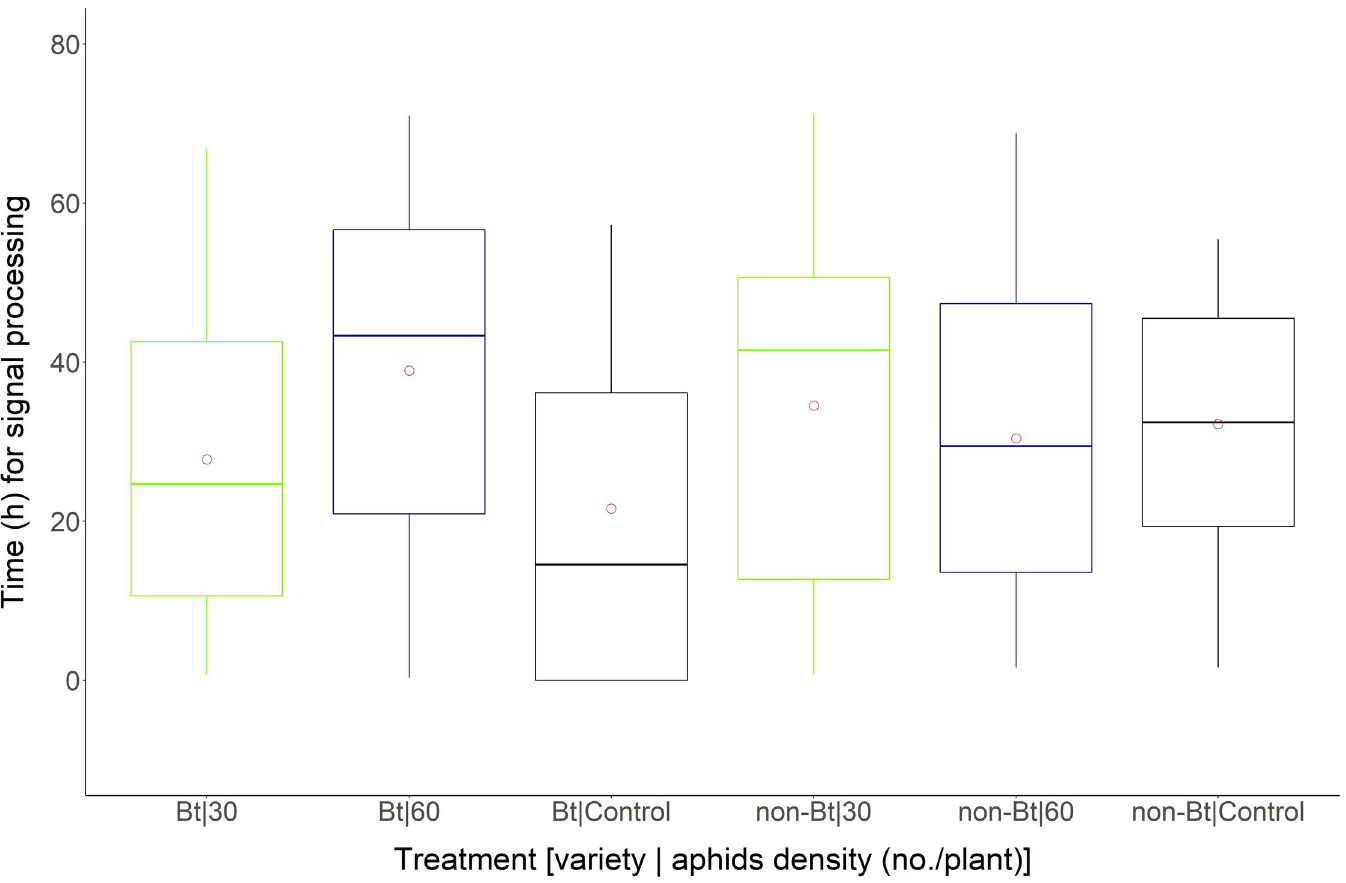
Fig 2. Boxplot of time (h) of exposure of Bt and non-Bt cotton plants to different densities of A . gossypii emitting potentials of variation (VPs) (mV). Bt and non-Bt cotton plants were infested at densities of 30 and 60 aphids/plant and in the absence of aphids (Control). Circle within the boxplot corresponds to mean of time for each